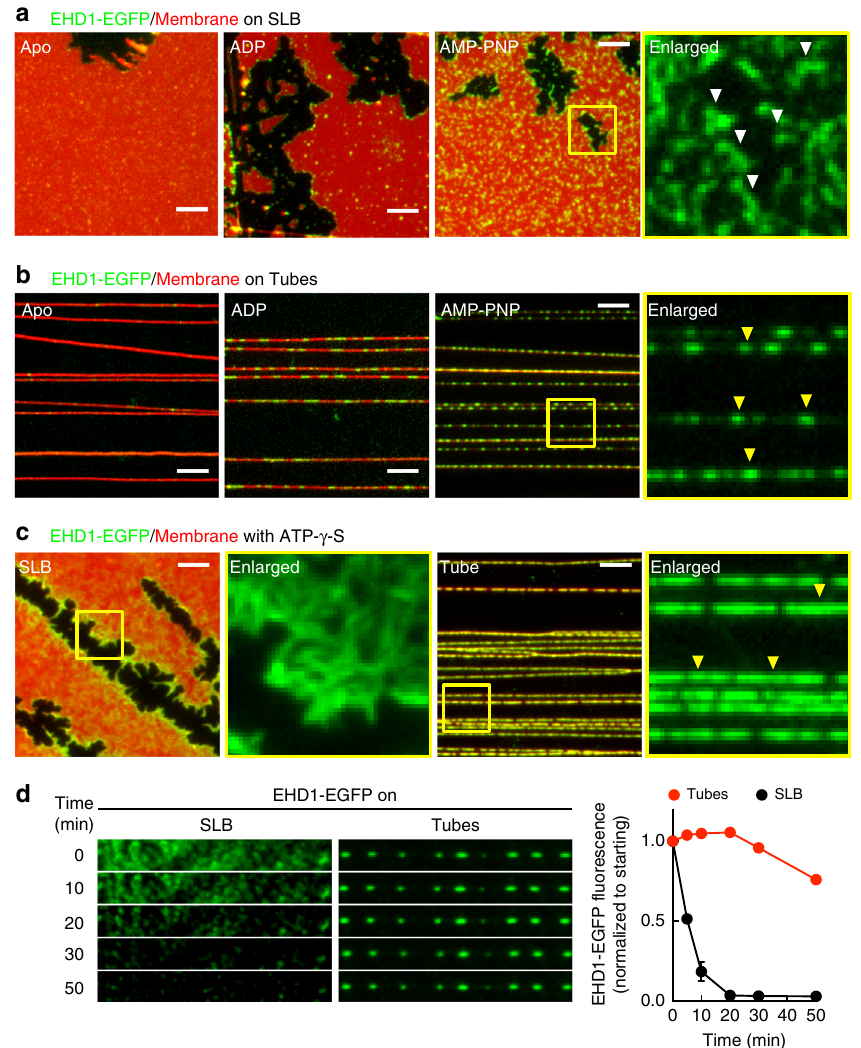
Fig. 4 EHD1 distribution and dynamics on membranes. Representative fl uorescence micrographs showing the distribution of EHD1-EGFP in the Apo, ADP- bound, and AMP-PNP-bound states on SLBs ( a ) and tubes ( b ). White and yellow arrowheads mark oligomers of EHD1-EGFP on the SLB and tubes, respectively. Scale bars = 5 μ m. c Representative fl uorescence micrographs showing the distribution of EHD1-EGFP with ATP- γ -S on the SLB and tubes. Yellow arrowheads mark oligomers of EHD1-EGFP on the tubes. Scale bars = 5 μ m. d Representative fl uorescence micrographs showing the effect of ATP addition to EHD1-EGFP assembled with ATP- γ -S on the SLB and tubes. Plot shows quantitation of fl uorescence intensities of EHD1-EGFP on the SLB and tubes. Data represent mean ± SD of n = 3 ROIs on the SLB and